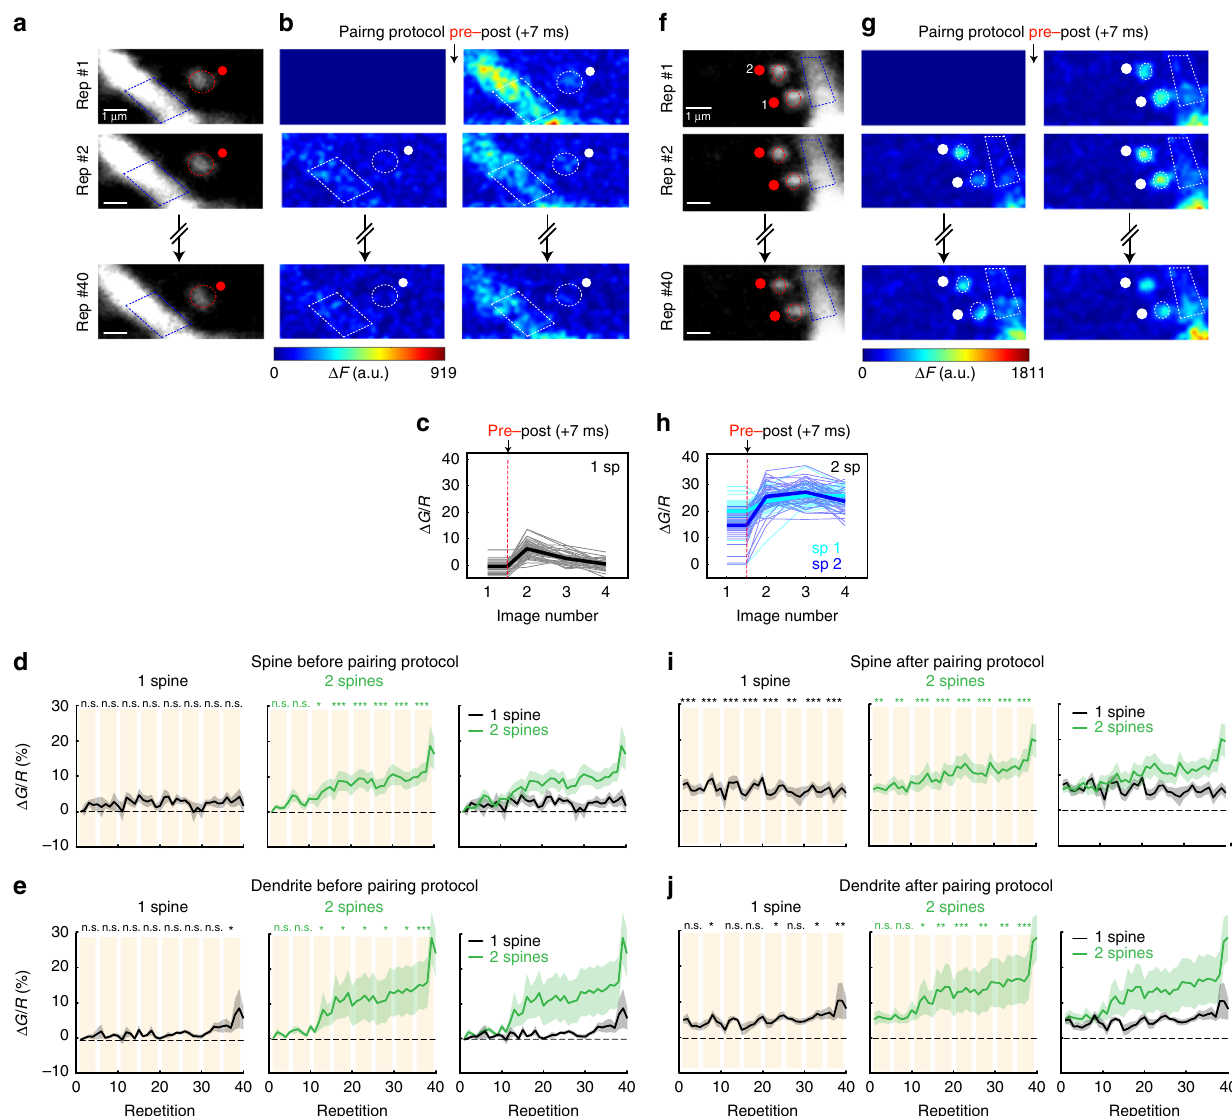
Fig. 6 Calcium dynamics in single and two clustered spines during t-LTP induction. a Single 2P images of a spine and dendrite from a L5 pyramidal neuron loaded with Alexa Fluor 594 (shown in a ) and Fluo-4 (shown in b ). Red ellipses and blue polygons indicate the ROIs selected for analysis. b Two- photon calcium signal images before (left panels) and after (right panels) a + 7 ms pre – post pairing. The 1st, 2nd, and 40th repetitions of the pairing protocol are shown. Change in calcium fl uorescence from baseline ( Δ F ) is color coded. Only positive changes in fl uorescence are shown. White ellipses and polygons indicate the ROIs selected for analysis. c Average and individual Δ G R traces from spine ROIs for each of the 40 repetitions during the experiment depicted in a , b . Dotted line is the time when pairing occurred. d , e Population averages of Δ G R measured in d spines and e dendrites before the pairing performed in one spine (left panels; P = 0.28 and 0.13, respectively, n = 7 spines and dendrites, from six neurons, and four mice) and two spines (middle panels; P < 0.0001 and P = 0.006, respectively, n = 12 spines and 6 dendrites, from four neurons, and four mice, one-way repeated-measures ANOVA). Right panels show Δ G R population averages for one (black lines) and two spines (green lines). f , g As in a , b , but for two clustered spines. h Average and individual Δ G R traces from ROIs (sp1 versus sp2) from each of the 40 repetitions during the pre – post pairing in the experiment depicted in f , g . Dotted line is the time when pairing occurred. i , j Population averages of Δ G R measured in i spines and j dendrites after the pairing in one spine (left panels; P < 0.0001 and P = 0.03, respectively, n = 7 spines and dendrites) and two spines (middle panels; P < 0.0001 and P = 0.0001, respectively, n = 12 spines and 6 dendrites, one-way repeated-measures ANOVA). Right panels show Δ G R population averages in one spine (black lines) and two spines (green lines). Shaded area represents SEM. n.s. not signi fi cant; * P < 0.05; ** P < 0.01; *** P < 0.001, post hoc Dunnet ’ s test. sp